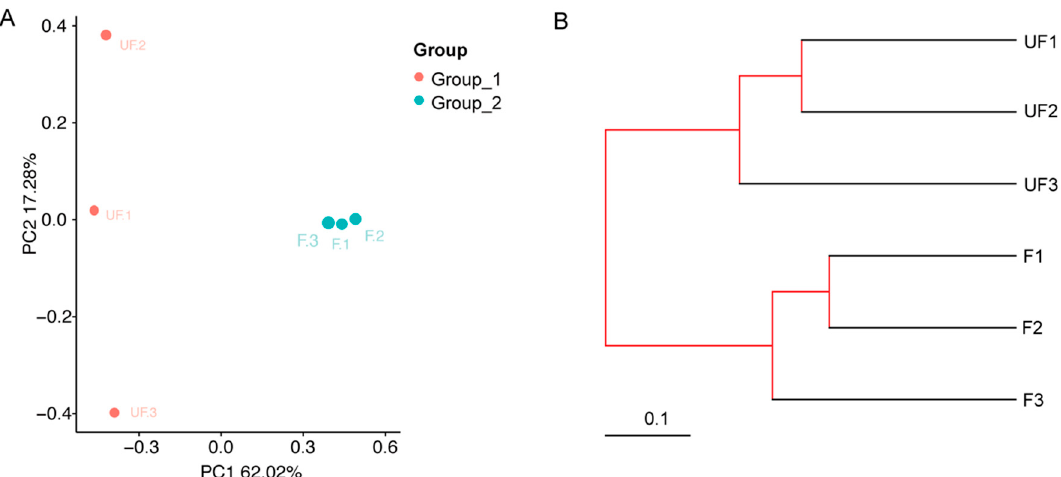
Figure 6. β -diversity analysis for the non-fertilized and fertilized eggs. ( A ) Principal coordinates analysis (PCoA) plots on the basis of weighted UniFrac distance matrices. ( B ) Unweighted pair group method with arithmetic mean (UPGMA) clustering on the basis of the unweighted UniFrac distance analysis.